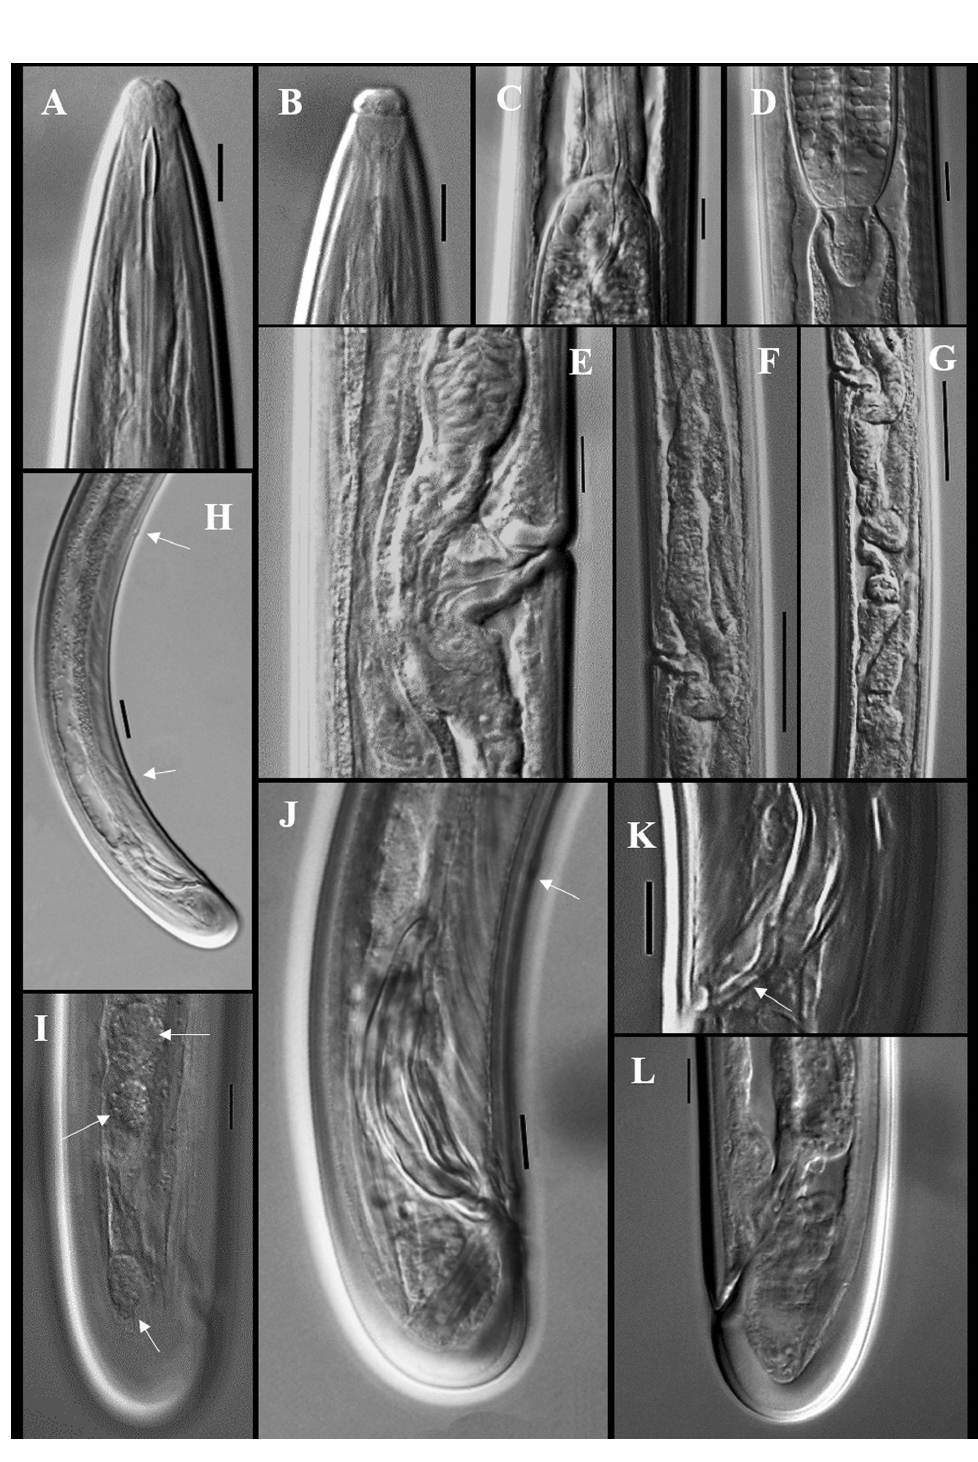
Fig. 4. Axonchium vallum Ahmad & Jairajpuri, 1982 (LM photographs). A . Anterior region. B . Anterior region showing amphid. C . Junction between two parts of pharynx. D . Cardia. E . Vulva and vagina. F – G . Female genital branches. H . Ventromedian supplements. I . Lateral glandular bodies. J . Male posterior end. K . Lateral guiding piece. L . Female posterior end. Scale bars: A–E, I–L = 10 µm; F–G = 50 µm; H = 20